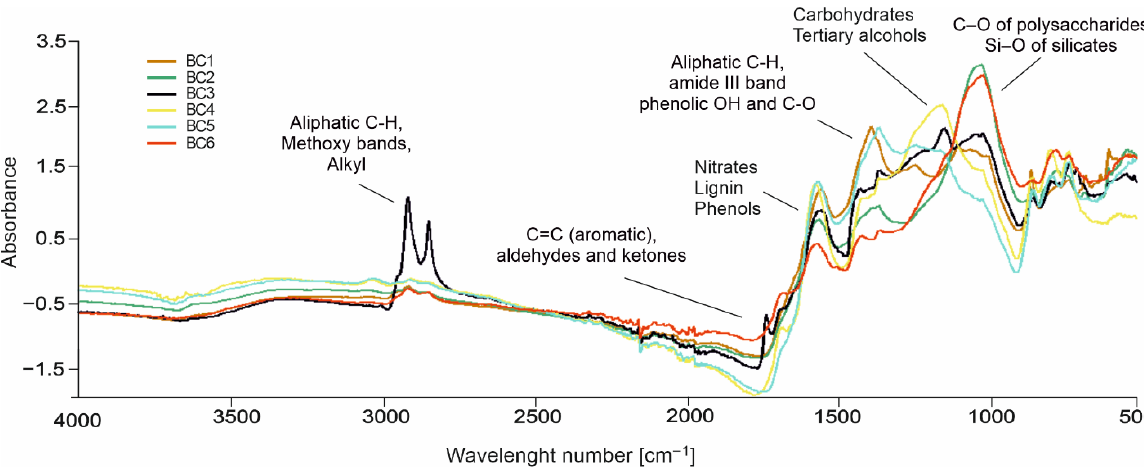
Figure 2. Mid-infrared spectra of biochars with identified bands.